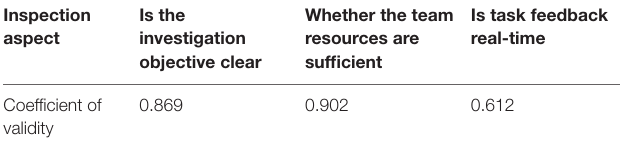
TABLE 2 | Questionnaire validity test.